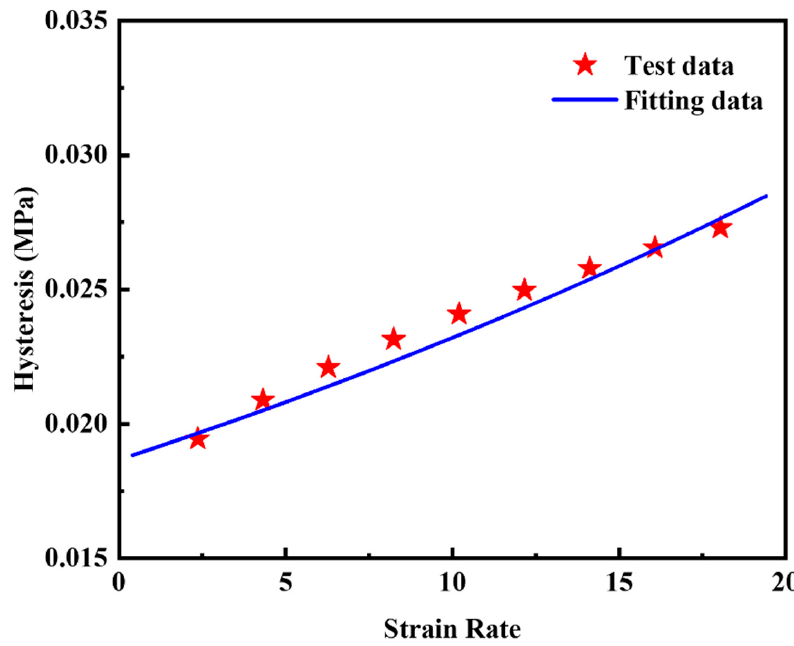
. ε 0 and fitting data of the silica filled S − SBR material at a constant strain Figure 12. Test data of h vs. ε  Figure 12. Test data of h vs. 0 amplitude of 0.4 and a constant temperature of 25 ◦ C. The coefficient of determination R 2 is